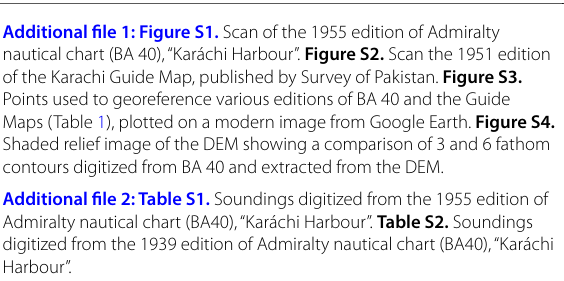
Additional file 2: Table S1. Soundings digitized from the 1955 edition of Admiralty nautical chart (BA40), “Karáchi Harbour”. Table S2. Soundings digitized from the 1939 edition of Admiralty nautical chart (BA40), “Karáchi Harbour”.